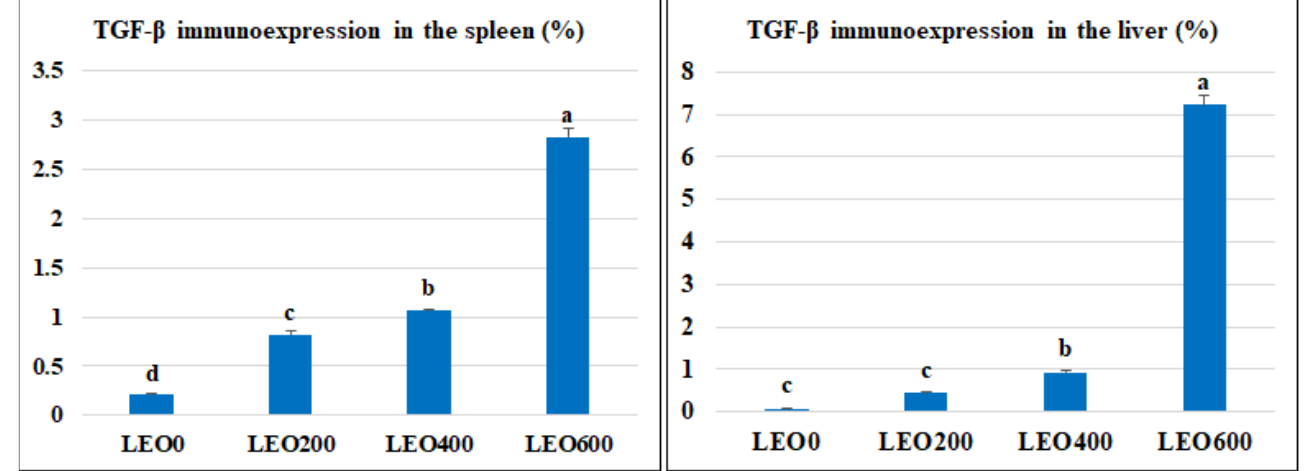
Figure 4. The morphometric analytic data in the spleen and liver of different experimental groups. LEO0, LEO200, LEO400, and LEO600: basal diets supplemented with 0, 200, 400, and 600 mg Kg − 1 lavender essential oil, respectively. a, b, c, d Means carrying different superscripts are significantly different at ( p < 0.05). TGF- β: transforming growth factor beta.